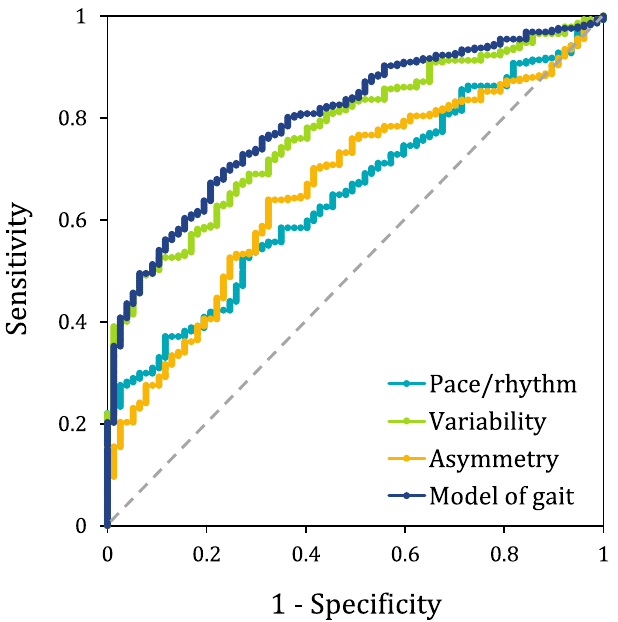
Figure 2. Receiver Operating Characteristic (ROC) curves assessing the ability of the three factor scores and of the overall gait model to discriminate between pwPD and HS. The light-blue line represents the pace/rhythm factor, the green line represents the variability factor, the yellow line represents the asymmetry factor, while the dark blue line represents the gait model with the three factor scores collapsed together. The grey dotted line represents the random classifier (“no discriminated” line), where the AUC is equal to